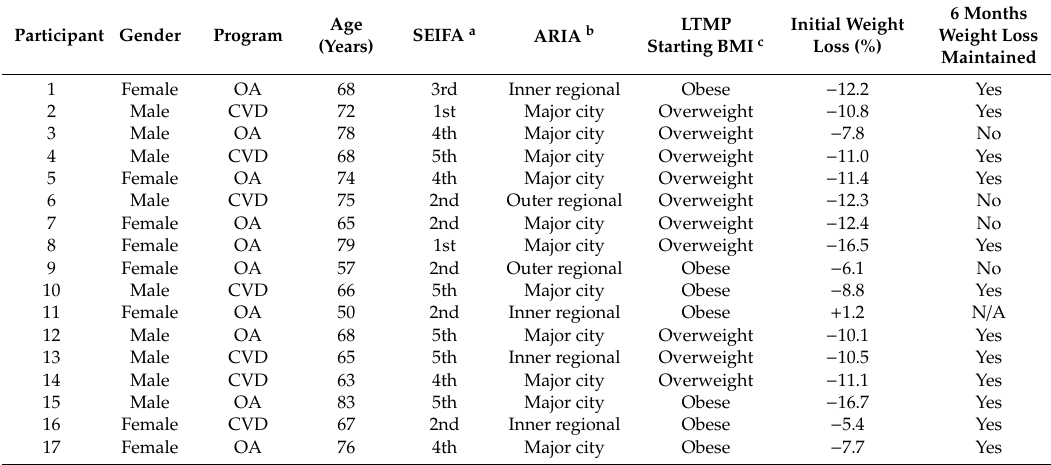
Table 1. Participant